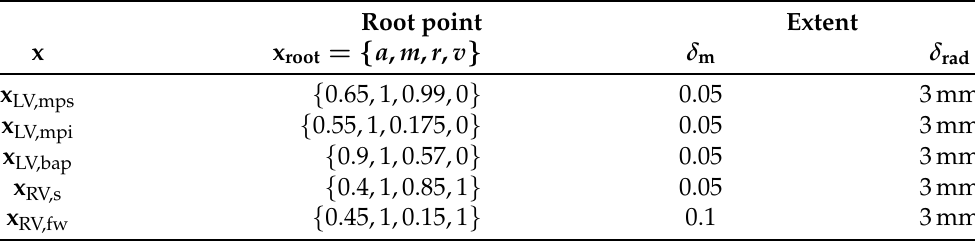
Table 2. Sites of earliest activation in terms of the coordinate system Cobiveco [42]: a apicobasal; m transmural; r rotational; v